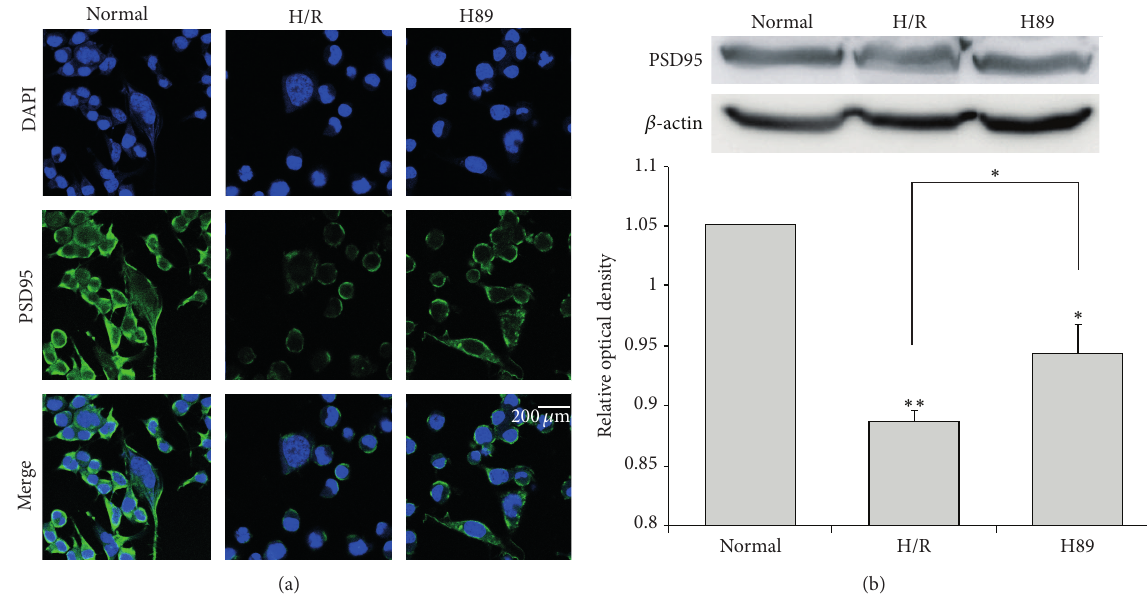
Figure 8: The measurement of PSD-95 expression in Neuro2A cells after H/R-induced injury. The level of PSD-95 was evaluated by immunocytochemistry. This image shows that the expression of PSD-95 in the H/R group was decreased compared to the normal group. PKA inhibitor H89 pretreatment increased the expression of PSD-95 in spite of hypoxia reperfusion injury. (b) Western blotting experiments showed that the relative protein expression of PSD-95 slightly increased in the H89 group compared to the hypoxia reperfusion group. 𝛽 -actin was used as an internal control. Data were expressed as mean ± S.E.M, and each experiment included 4 repeats per condition. Differences were considered significant at ∗ 𝑃 < 0.05 and ∗∗ 𝑃 < 0.001 . Scale bar: 200 𝜇 m, PSD-95: green, 4 󸀠 , 6-diamidino-2-phenylindole (DAPI): blue, normal: the normal control group, H/R: 4hr hypoxia and 18hr reperfusion injury group, and H89: 2 hr PKA inhibitor H89 treatment group before 4hr hypoxia and 18hr reperfusion